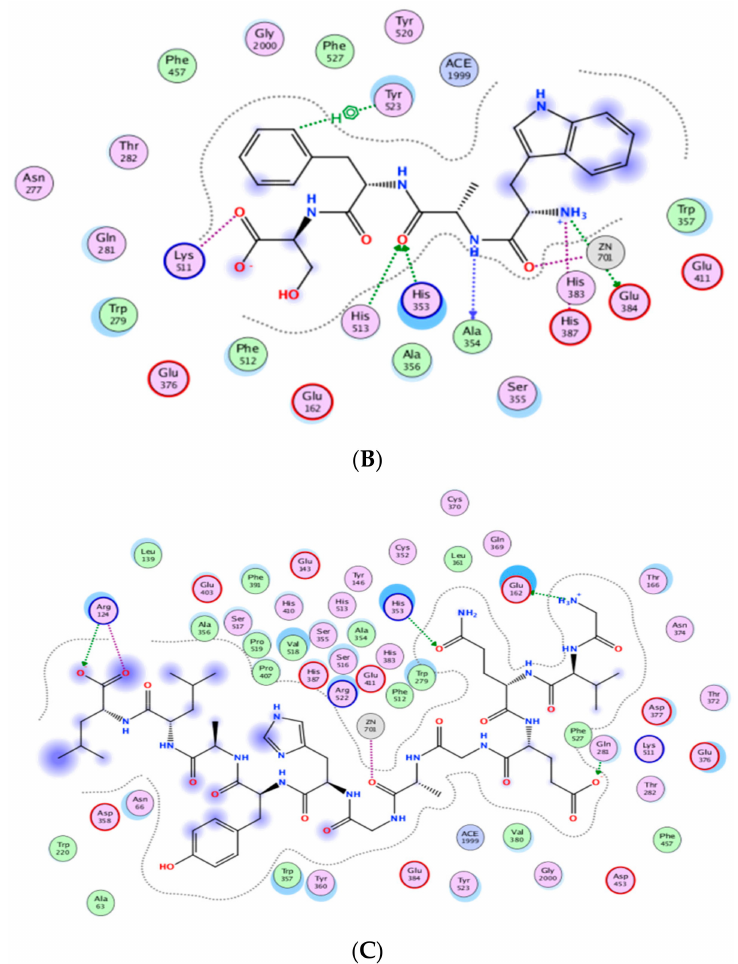
Figure 3. Automated molecular docking of YLLLK ( A ), WAFS ( B ), and GVQEGAGHYALL ( C ) at the angiotensin-converting enzyme (ACE) active site. ACE hydrophobic residues are represented in green, positively charged residues in blue, and negatively charged residues in red; hydrogen bonds are purple arrows, polar residues are in turquoise color, and other residues and the zinc atom are represented automatically. Image obtained with Accelrys DS Visualizer